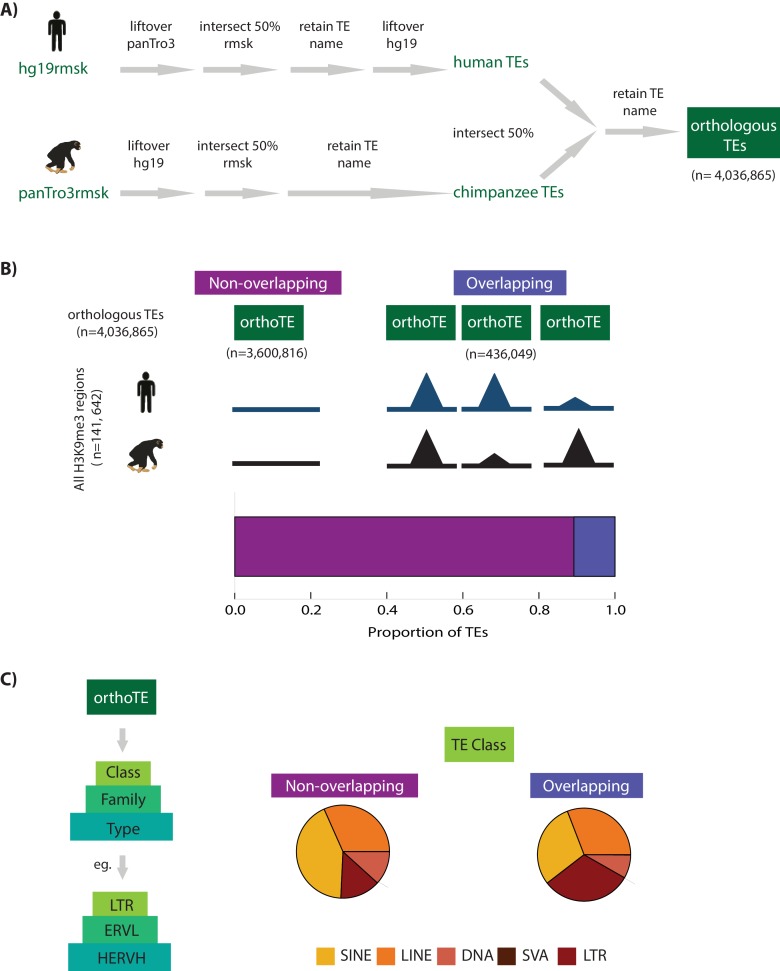
Transposable element silencing is associated with particular transposable element classes.(A) Bioinformatic pipeline used to identify TEs that are orthologous between humans and chimpanzees using RepeatMasker (rmsk) tracks in each species. (B) The proportion of all TEs that overlap an orthologous H3K9me3 region (H3K9me3 peak identified in at least one individual of one species) (purple) compared to those that do not overlap an orthologous H3K9me3 region (magenta). (C) Each orthologous TE instance is further hierarchically classified into Class, Family and Type. The proportion of all orthologous TEs belonging to the five main TE classes (SINE: yellow, LINE: orange, DNA: peach, SVA: brown, LTR: red) that do not overlap an H3K9me3 region in either species, and the proportion of TEs that do overlap a H3K9me3 region. The small number of SVA elements means that this class is not visible in the pie chart. Also see Figure 2—figure supplement 1.